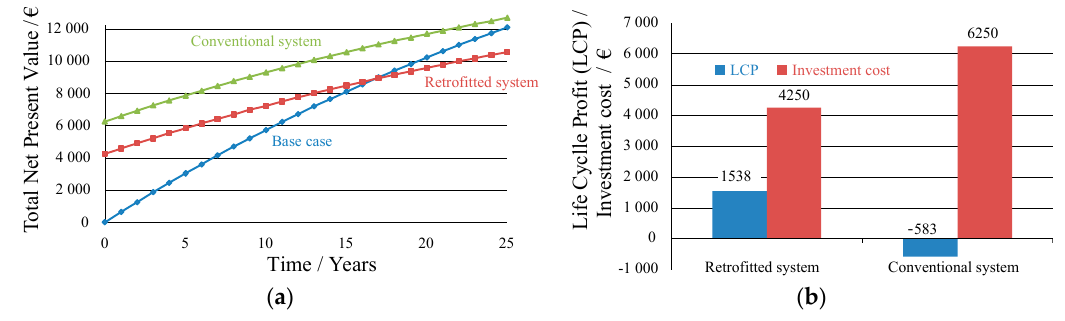
Figure 9. ( a ) Life cycle cost based on net present value for the base case (without solar energy), retrofitted system, and a conventional solar domestic hot water system; ( b ) Life cycle profit (LCP) and investment cost for the retrofitted system and the conventional systems.